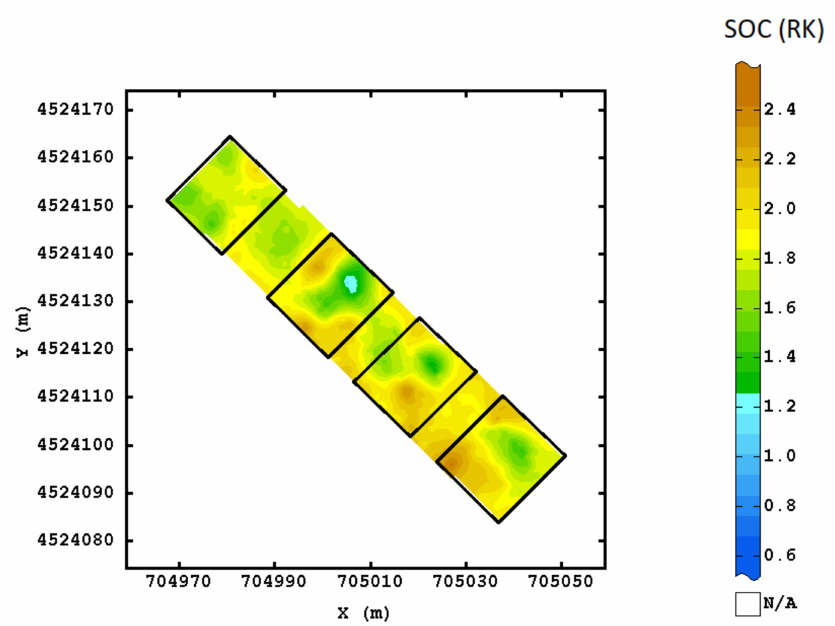
Figure 7. Map of SOC obtained with regression kriging. The black polygons indicate the four blocks in the RCB experimental